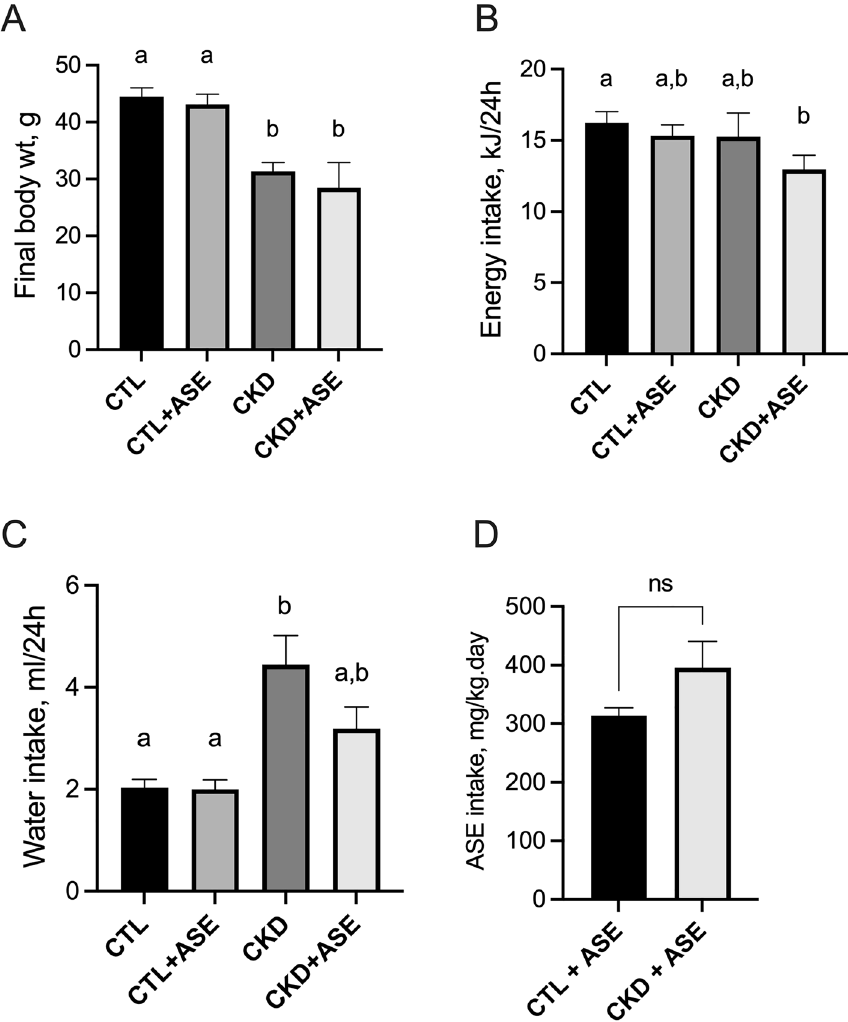
Figure 2. Body weight gain, cumulative water intake, and mean food intake in experimental mice. Final body weight ( A ), mean energy intake ( B ), mean water intake ( C ) and mean daily ASE consumption ( D ) in experimental mice. Data are expressed as means ± SD (n = 9–10 for each group). Significant differences were determined by two-way ANOVA followed by Tukey’s multiple comparison test. Different letters indicate a significant difference between groups at the P < 0.05